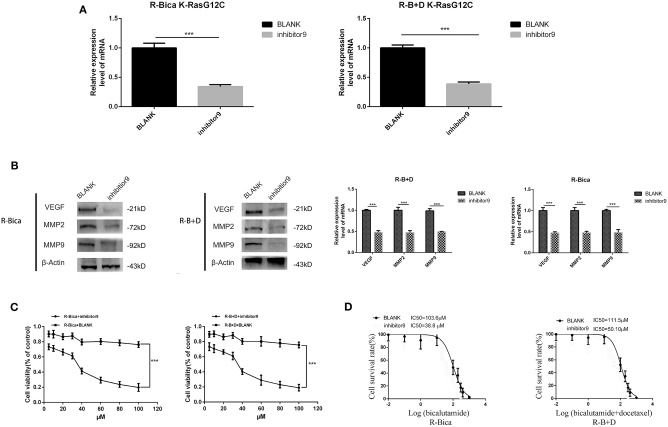
Inhibitor 9 regulates protein and mRNA expression of invasion-related factors and partly restored drug sensitivity. (A,B) The expression of VEGF, MMP2, and MMP9 in CRPC cells was examined by qPCR and Western blot. (C) CRPC cells were incubated with increasing concentrations of inhibitor 9 (5, 10, 20, 30, 40, 60, 80, and 100 μM) or BLANK for 48 h, and cell viability was analyzed by CCK-8 assay. (D) R-Bica cells were incubated with increasing concentrations of bicalutamide, while R-B+D cells were incubated with increasing concentrations of bicalutamide and docetaxel for 48 h, and the IC50 of R-Bica and R-B+D cells following treatment with inhibitor 9 and BLANK was determined by CCK-8 assay. ***P < 0.001.